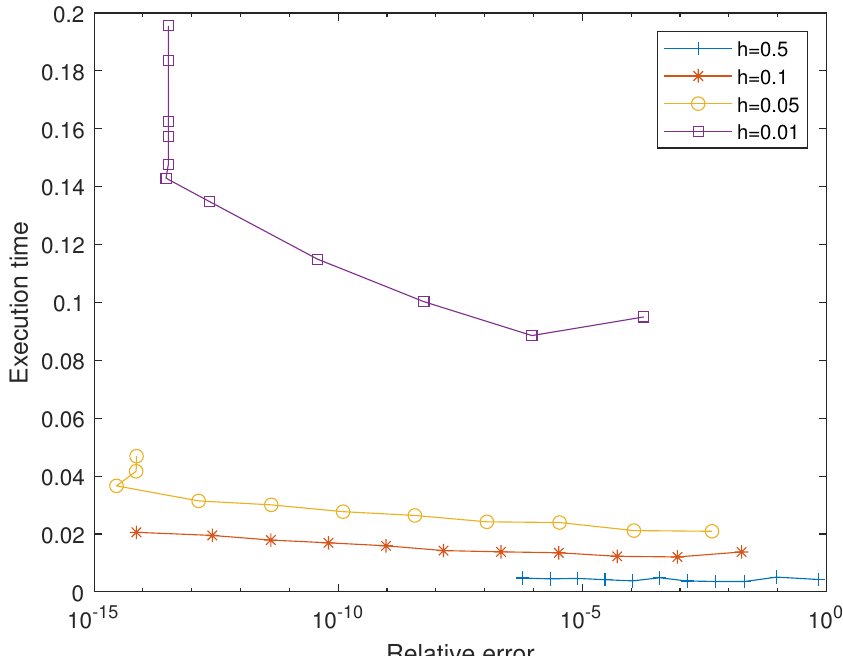
Figure 7. Execution time, for the nonlinear matrix problem (35), versus relative